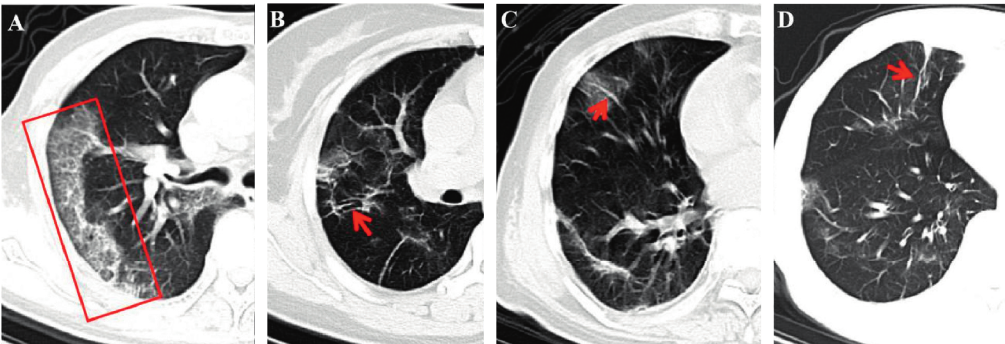
Figure 3: (a) A 79-year-old male COVID-19 patient with prolonged fever for 10 days. The CTdisplays the reticular pattern in the right upper lobe (red rectangle) (5 days after the onset of initial symptoms). (b) A 40-year-old female confirmed patient with running nose and whole- body pain for 11 days. The bronchial wall thickening is demonstrated on the follow-up CT (20 days after initial symptoms onset) (red arrow). (c) A 79-year-old male COVID-19 patient with prolonged fever for 10 days. The CTdisplays the vascular enlargement through the lesion in the right middle lobe (red arrow) (4 days after the onset of initial symptoms). (d) The same patient in (c) and the fibrosis is left after treatment for 10 days (red arrow).